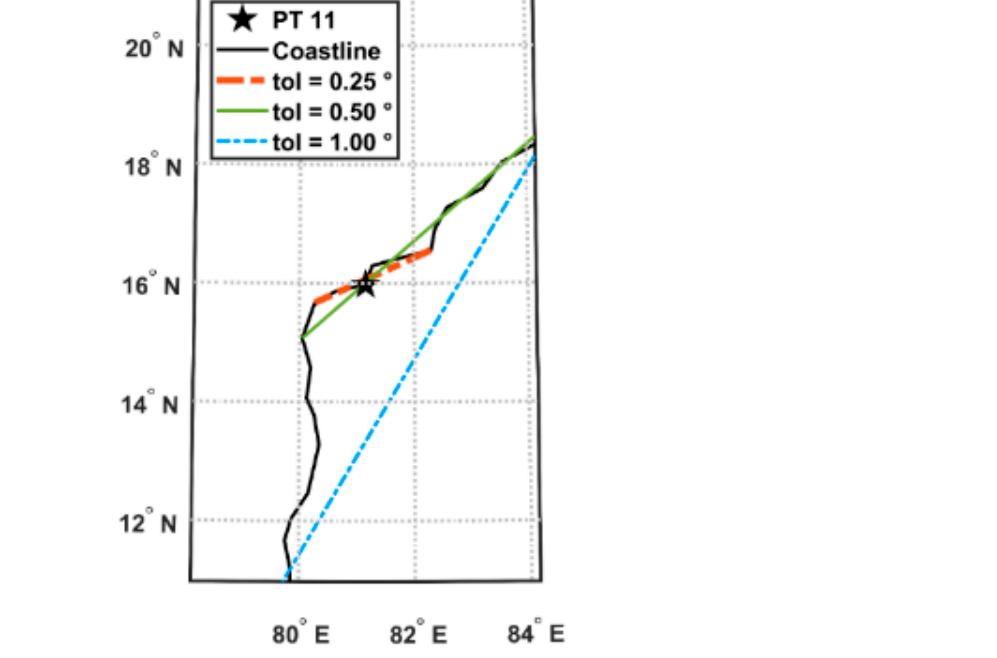
Figure 3. Linear approximations of the coastline at coastal point 11 for three different tolerance parameters of line simplification.